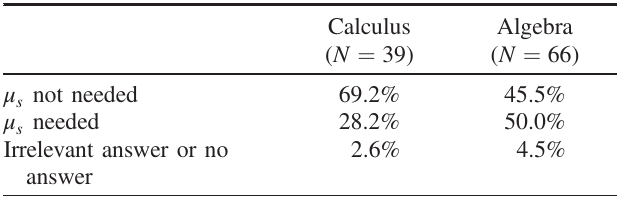
TABLE IX. Percentage of students in intervention group 3